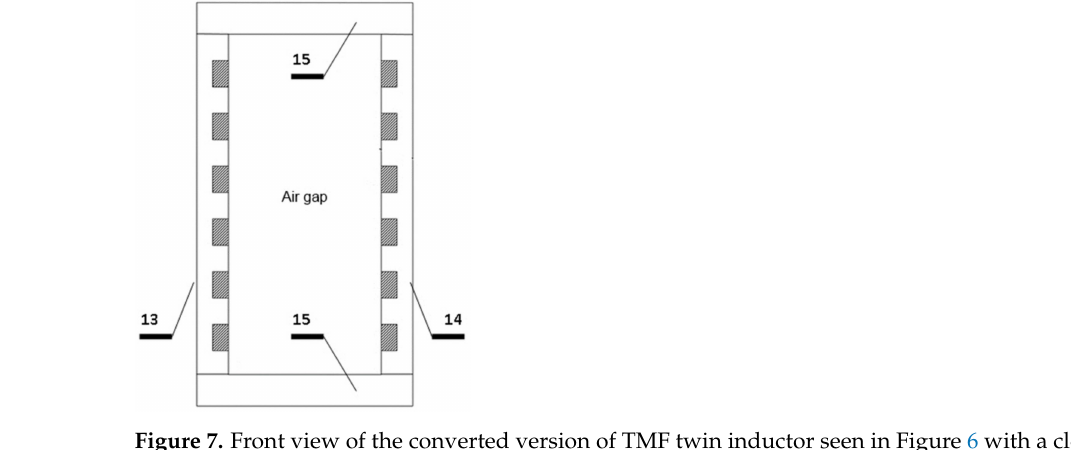
Figure 7. Front view of the converted version of TMF twin inductor seen in Figure 6 with a closed magnetic circuit. This inductor was constructed by changing the arched inductor sections (by converting them into plane ones, “13” and “14”) without representing the coil heads.